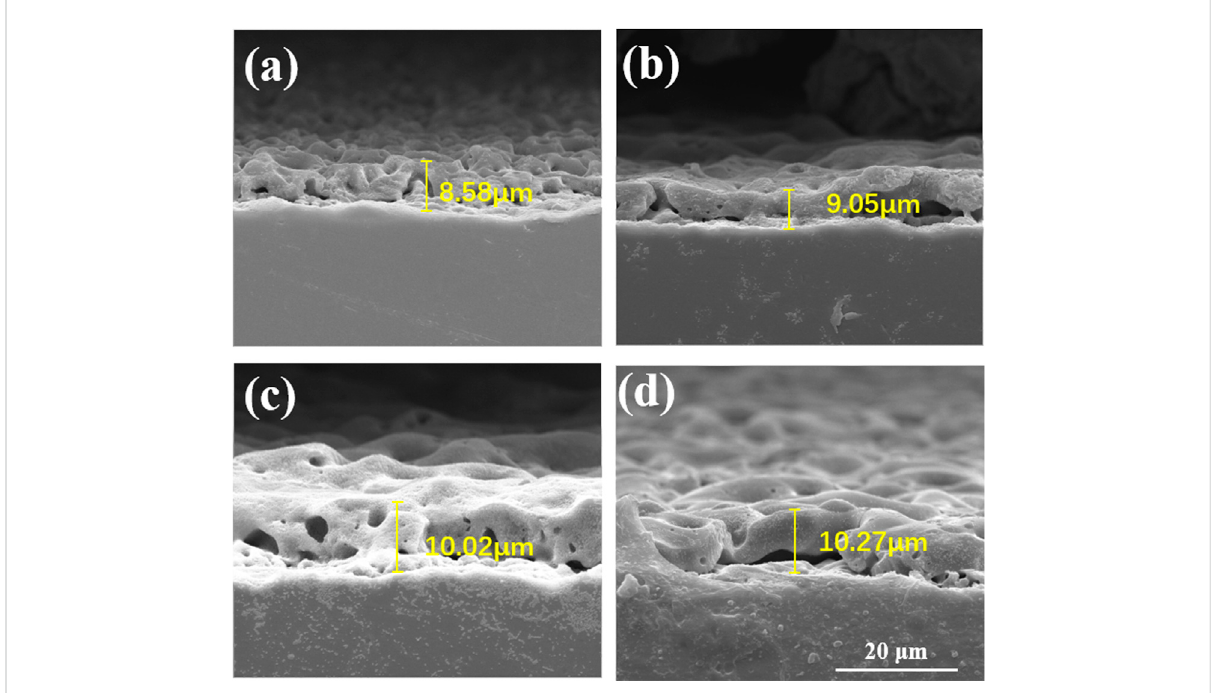
FIGURE 2 Cross-section morphologies of different coatings: (A) 0Cu-MAO, (B) 0.5Cu-MAO, (C) 1Cu-MAO, (D) 2Cu-MAO.